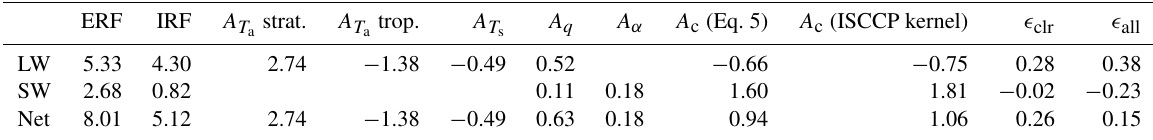
Table 3. IPSL-CM6A-LR forcing and adjustments for the 4 × CO 2 experiment using the HadGEM3-GA7.1 kernel. Fluxes are given in Wm − 2 . A T strat. and A T trop. are stratospheric and tropospheric temperature adjustments. a a ERF IRF A T a